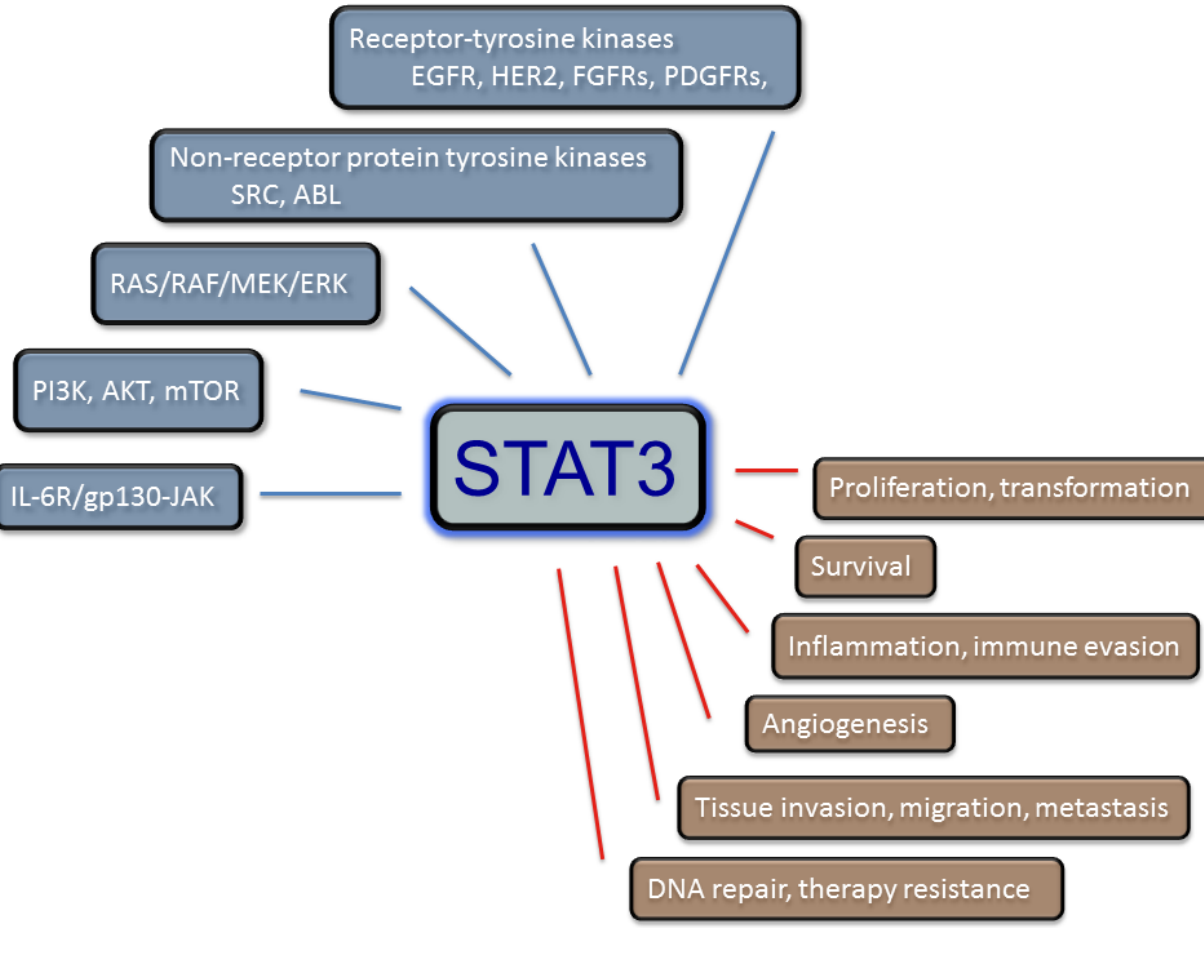
Figure 1. STAT3 modulates several signaling pathways and affects numerous cellular